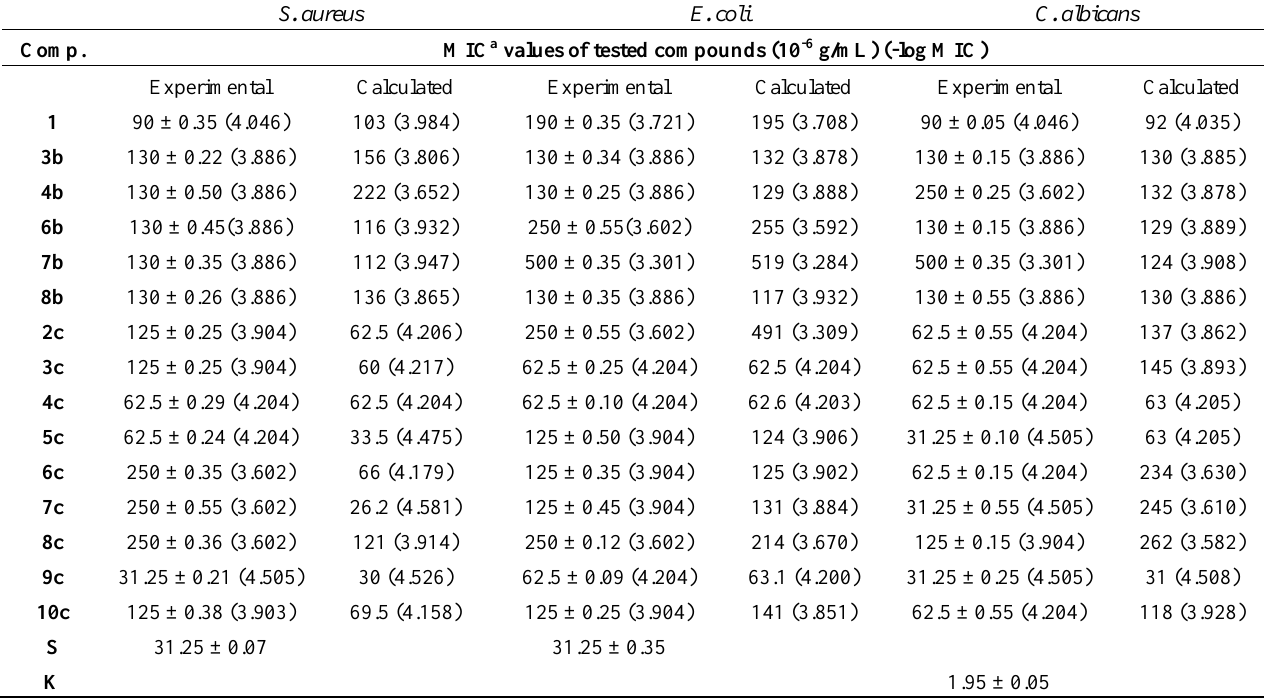
Table 1. Antimicrobial activity of synthetic coumarin